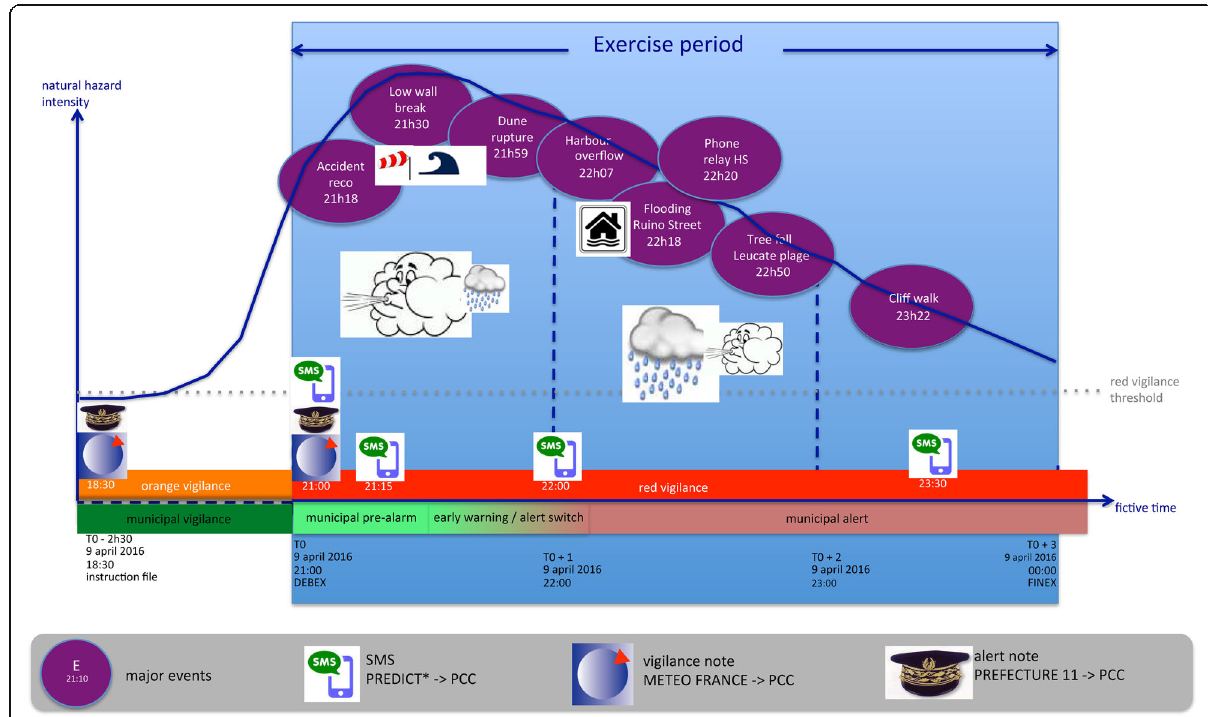
Fig. 2 Flowchart of the roll-out of the crisis exercise, March 2016. Source: ©Master GGRC, 2016 (PCC: municipal post of command; PREDICT: consultancy, service provider for the local authority; DEBEX: start of exercise; FINEX: end of